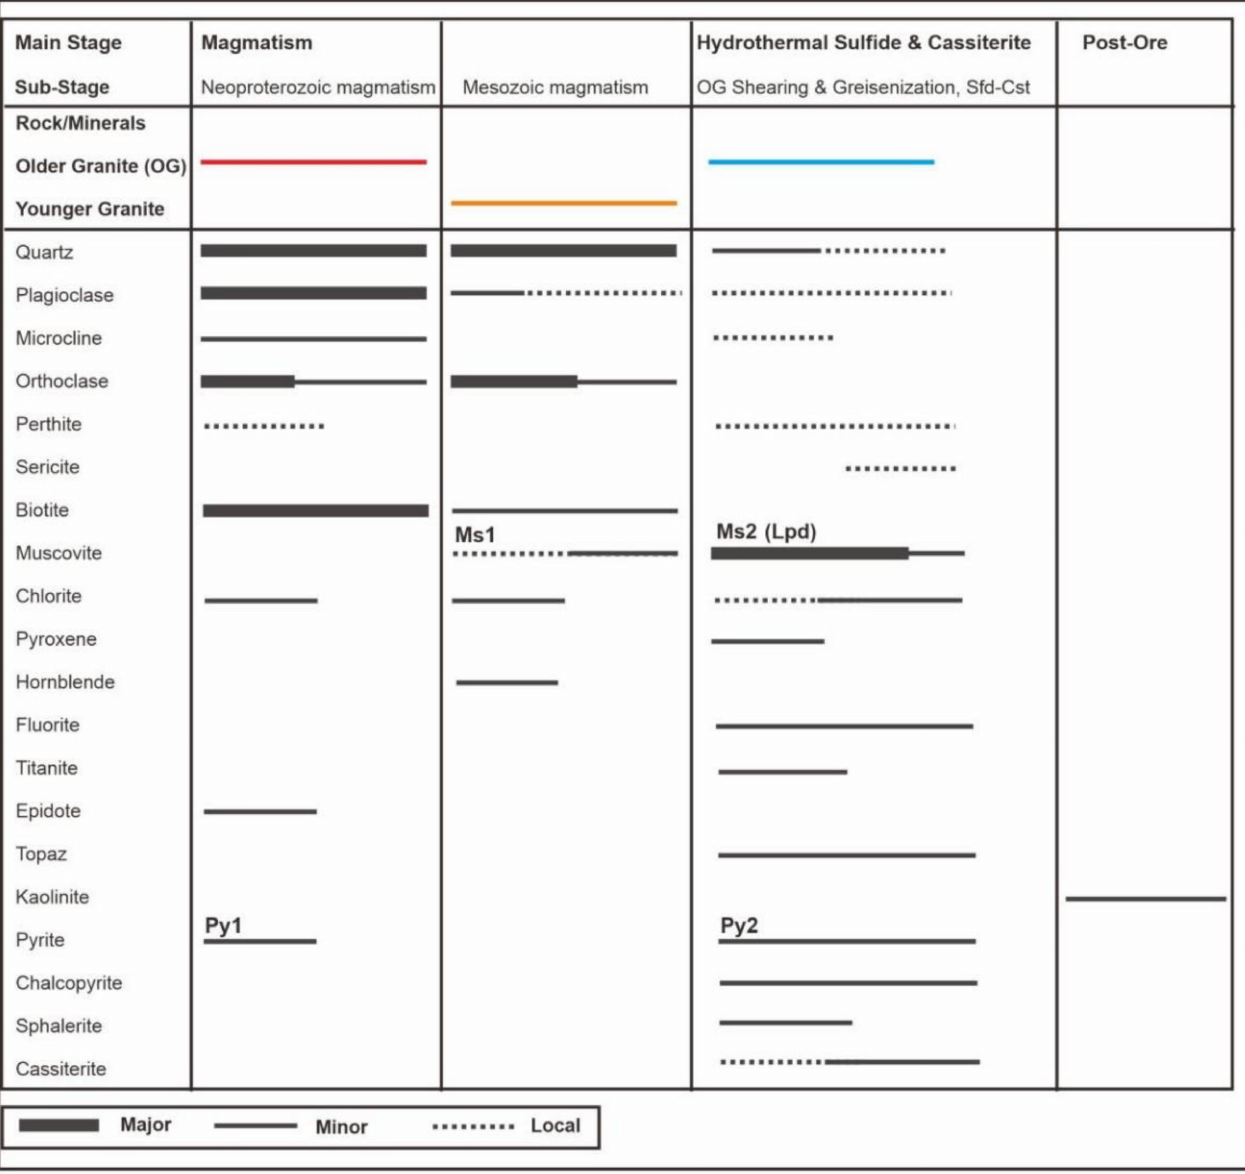
Figure 10. The simplified paragenetic sequence of the mineralized zone from the Gindi Akwati deposit is interpreted from texture, reflected and transmitted light microscopy, and alteration patterns. The bold lines indicate high abundance, the thin lines represent minor amounts, and the dashed lines indicate the local occurrence of trace amounts of uncertainty in determining the paragenetic sequence due to the lack of a clear textural